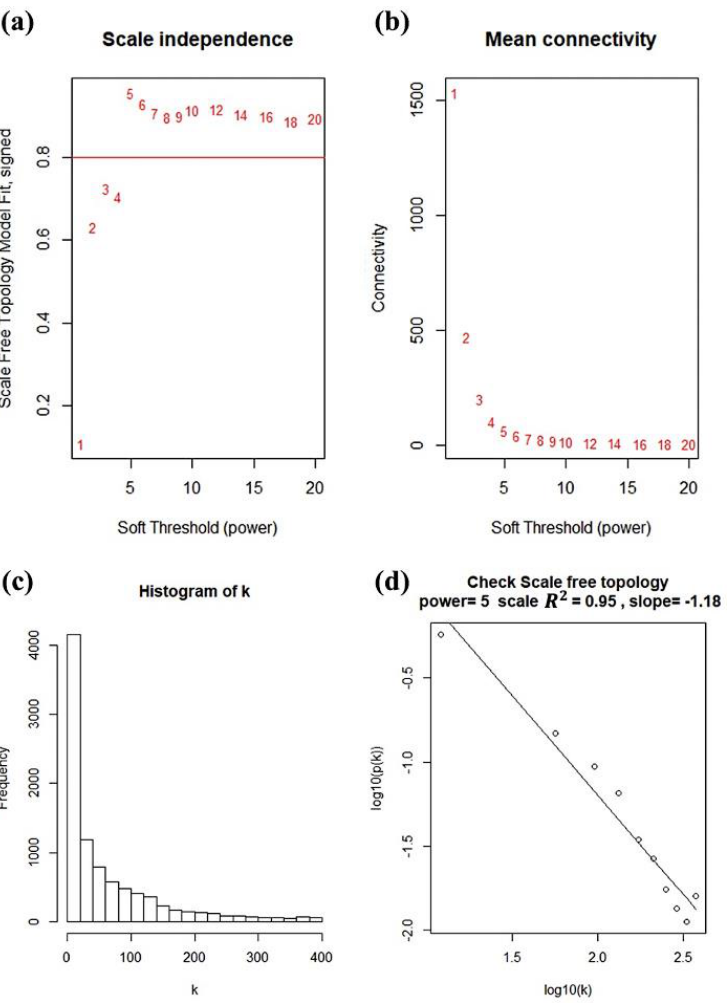
Figure 3. Determination of soft thresholding power in WGCNA. ( a ) Analysis of the scale-free fit index for various soft thresholding powers β . ( b ) Analysis of the mean connectivity for various soft thresholding powers. ( c ) Histogram of connectivity distribution when β = 5. ( d ) Checking the scale free topology when β = 5.